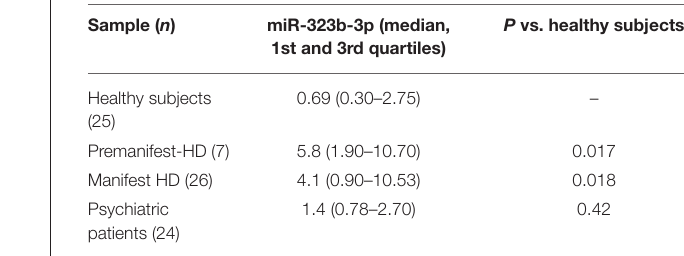
TABLE 2 | Plasma levels of miR-323b-3p in mHTT carriers and control